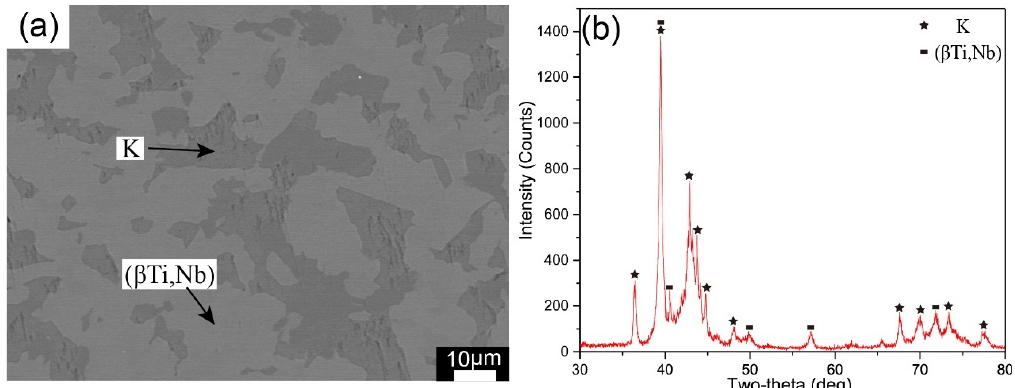
Figure 18. Alloy B8 annealed at 1273K for 60 days: ( a ) BSE images, ( b ) XRD patterns.